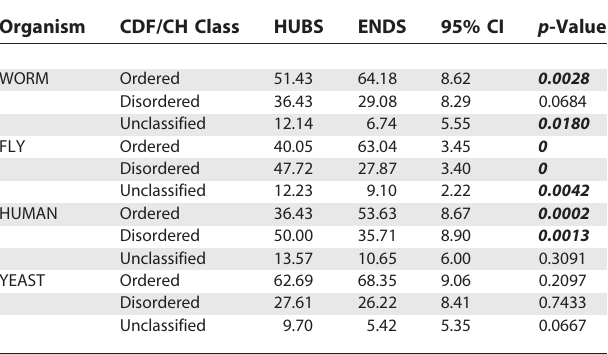
The percentages of ordered, disordered, and unclassified proteins in each dataset are shown. Bold and italic p -values are statistically significant with p , 0.05. DOI: